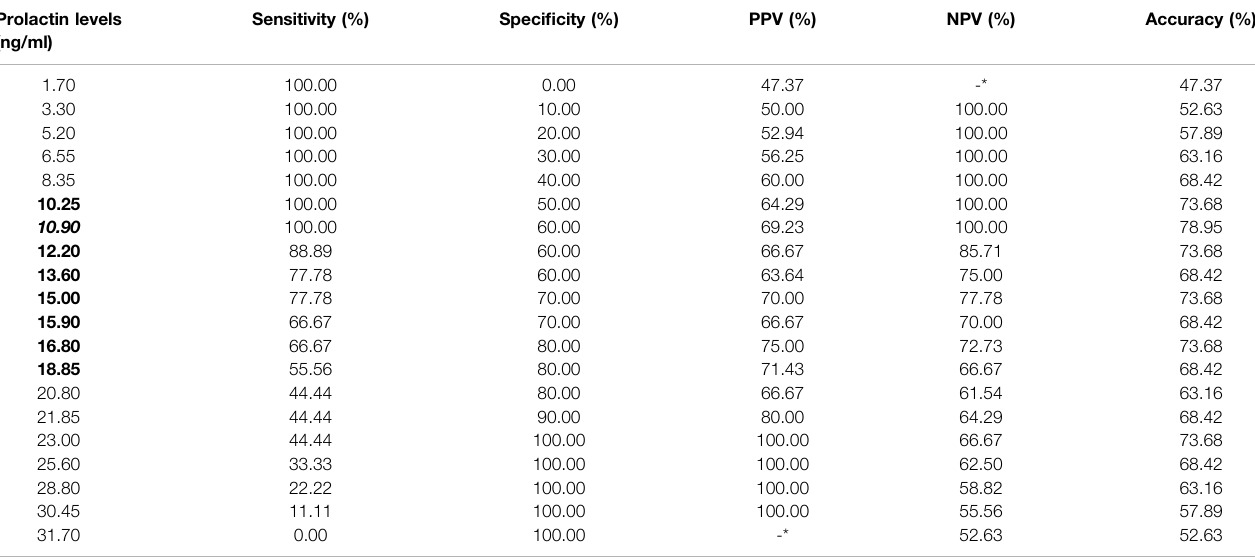
TABLE 6 | Sensitivity, speci fi city, and accuracy of prolactin levels predicting risperidone response. Prolactin levels Sensitivity (%) Speci fi city (ng/ml)